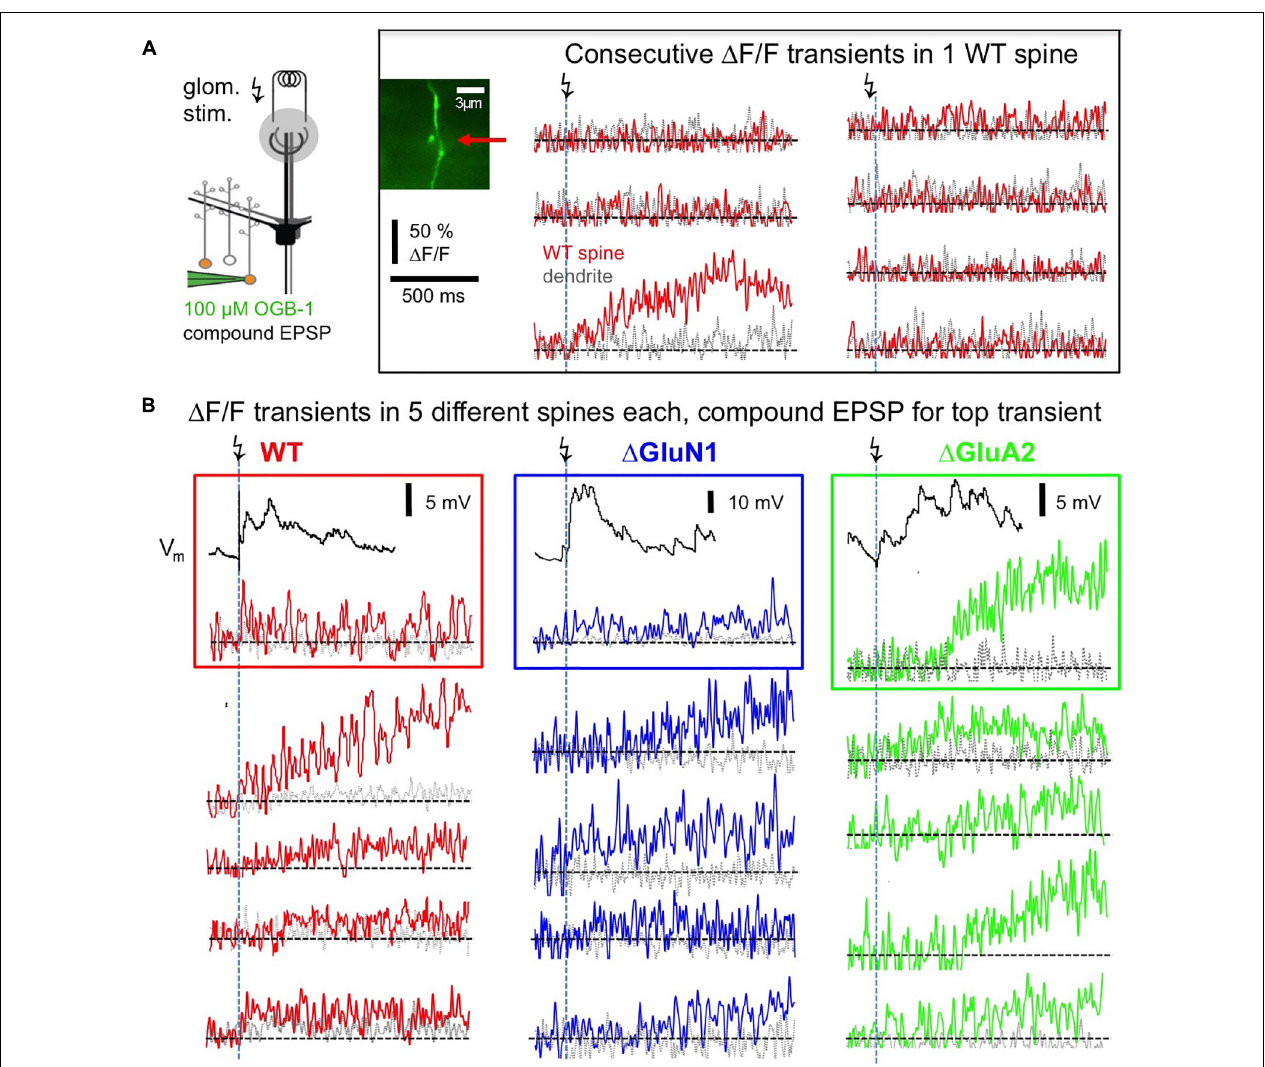
FIGURE 3 | Postsynaptic responses in adult WT, (cid:49) GluA2 and (cid:49) GluN1 GC spines. (A) Left: Scheme of experiment (modified from Abraham et al., 2010, their Figure 2 ). Electrical glomerular stimulation and whole-cell recording of the resulting compound EPSP from a GC, including two-photon imaging of a responding spine and its adjacent dendritic shaft. Genetically modified GCs ( (cid:49) GluA2 and (cid:49) GluN1) were identified by the expression of the fluorescent construct Kusabira-Orange. Middle: scan of a WT spine and dendrite. Right: line scans through the spine and dendrite during consecutive glomerular stimulations. Only one response occurred (3rd trace), that shows a slowly evolving Ca 2 + transient confined to the spine head. (B) Single responses from other spines, with each trace imaged in a different spine. Same scales for (cid:49) F/F and time as in (A) . Top transients with their associated compound EPSP recordings. Left (red): WT GCs. Middle (blue): (cid:49) GluN1 GCs. Right (green): (cid:49) GluA2 GCs. Note the larger size and yet slower evolution compared to WT and (cid:49) GluN1.